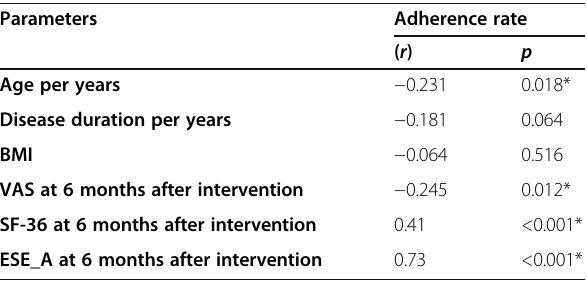
Table 5 Correlation between home exercise adherence rate and some of the related factors and outcome measures after (6 months) home exercise period Parameters Adherence